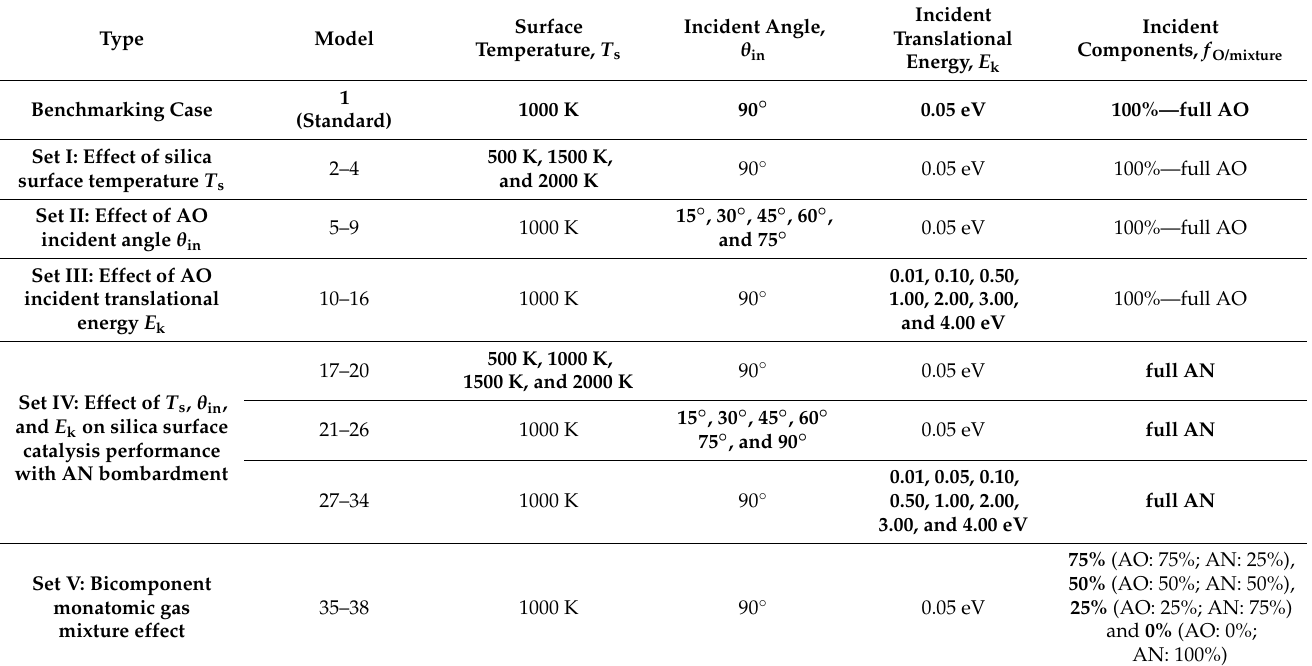
Table 1. Parameters of GSI models investigated in the present work.